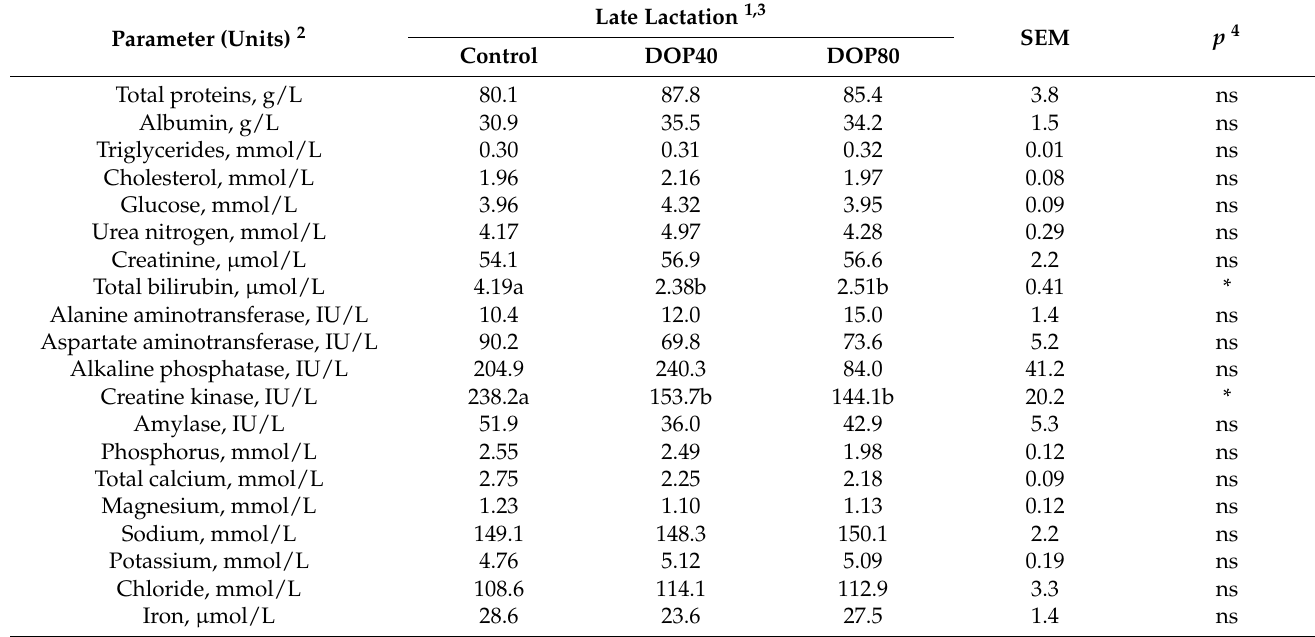
Table 6. Effects of experimental diets 1 on blood biochemical parameters of goats in late lactation (150 to 180 days). Parameter (Units)